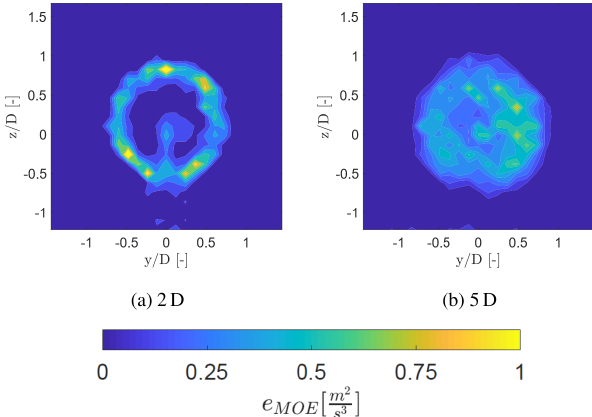
Figure 17. Normalised error e u u [%] at 2 and 5 D for the inflow without a grid.